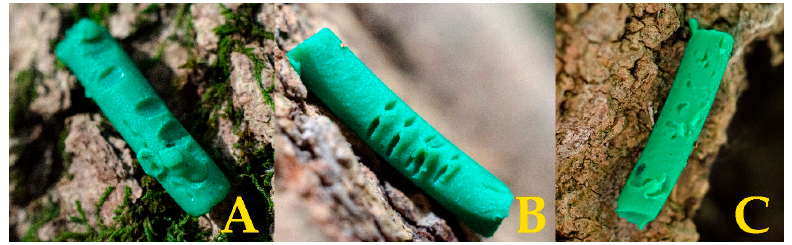
Figure 3. Characteristic marks left by different predator groups on dummy caterpillars. A—small mammals, B—arthropods, C—birds.